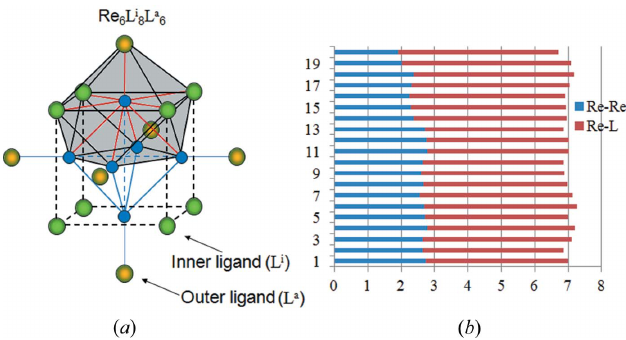
Figure 2 Structural and bonding features of the Re 6 -cluster compounds. ( a ) Octahedral Re 6 -cluster surrounded by eight inner and six outer ligands. The coordination polyhedron around an individual Re atom is marked in grey. ( b ) Validity of the conservation principle for the Re atoms in the Re 6 -cluster complexes. The numbers in the vertical scale correspond to the respective compounds in Table S2 in the supporting information, while the abscissa values correspond to the BO sum for the various